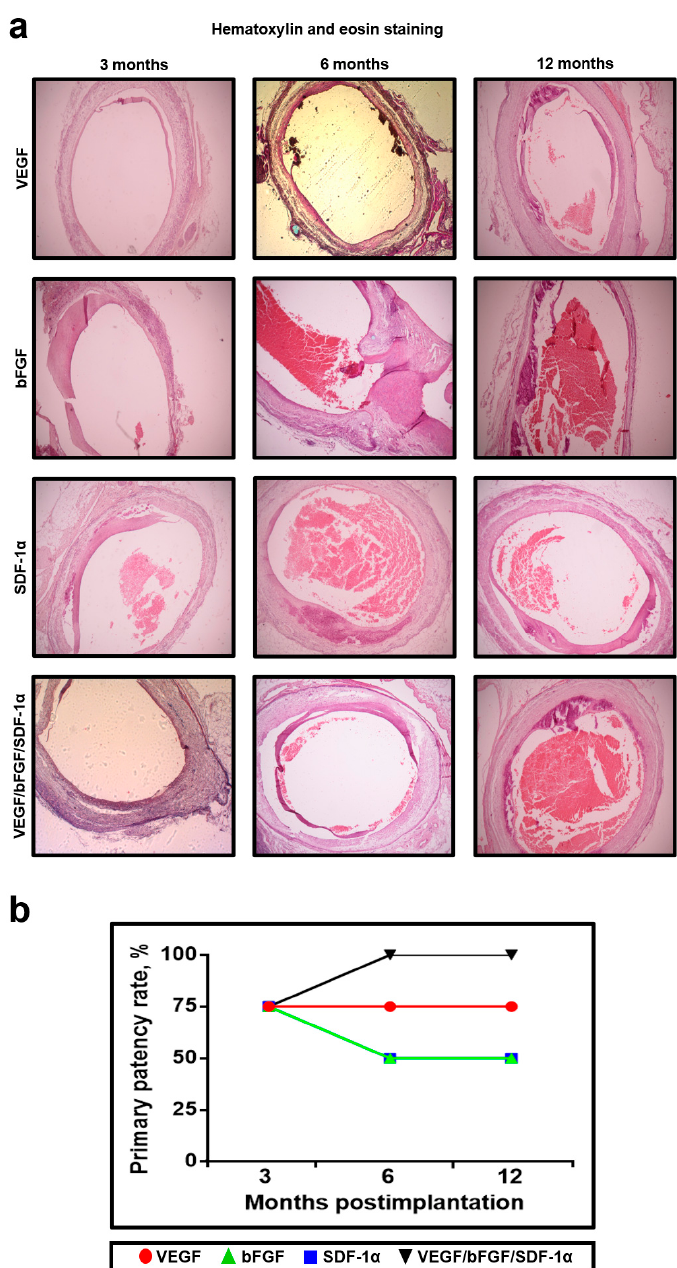
Figure 5. Grafts modified with a combination of VEGF, bFGF, and SDF-1 α have a higher long- term primary patency rate than the grafts with either of these factors. ( a ) Representative images of the H&E-stained grafts modified with either VEGF, bFGF, SDF-1 α , or all three factors at 3, 6 and 12 months postimplantation, × 50 magnification; ( b ) Quantitative image analysis, each dot represents a primary patency rate with respect to the experimental group and time